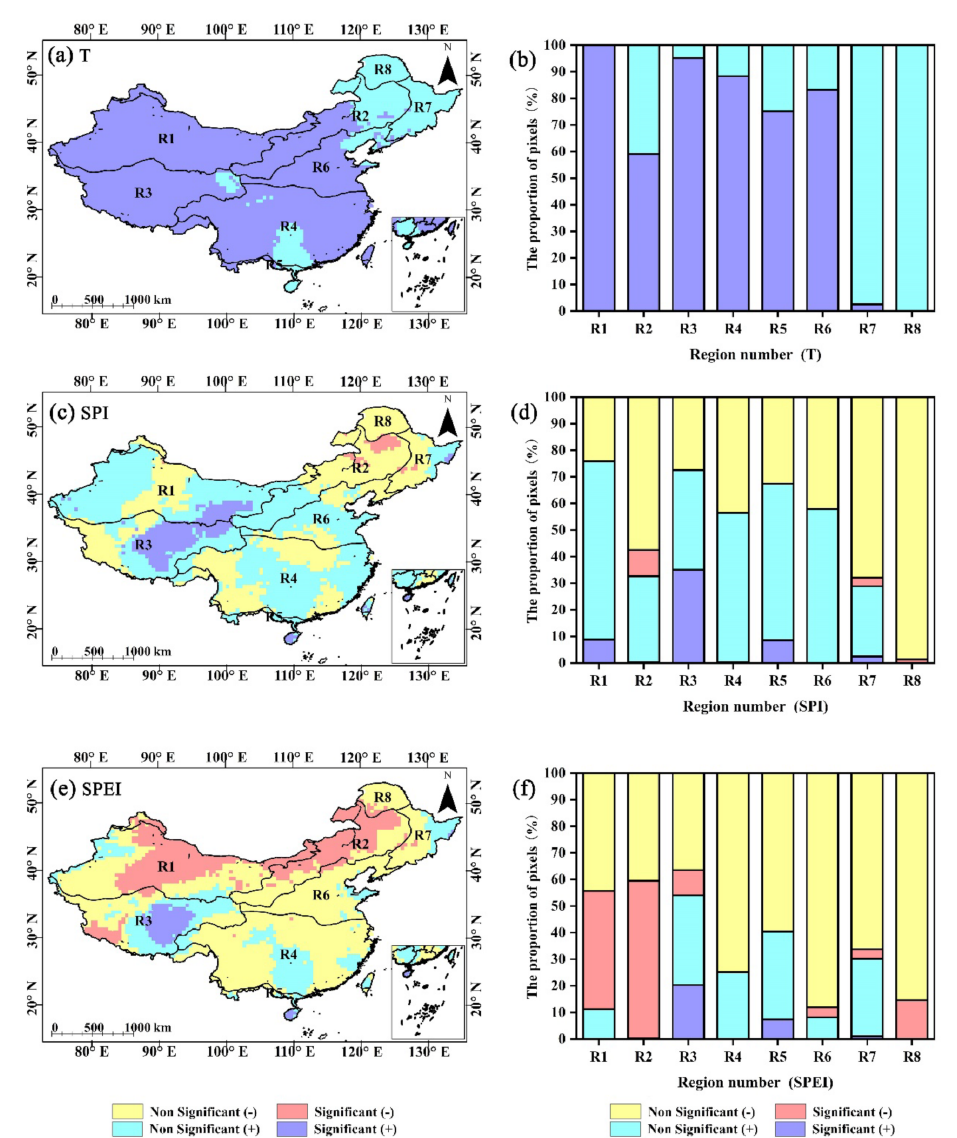
Figure 3. Temperature and standardized precipitation index (SPI)/standardized precipitation evapotranspiration index (SPEI) trends from 1982 to 2017. ( a , c , e ) represent the spatial distributions of the temperature, SPI, and SPEI trends, respectively; ( b , d , f ) represent the proportion of pixels with different temperature, SPI, and SPEI trends, respectively, to the total number of pixels in the eight vegetation regions of